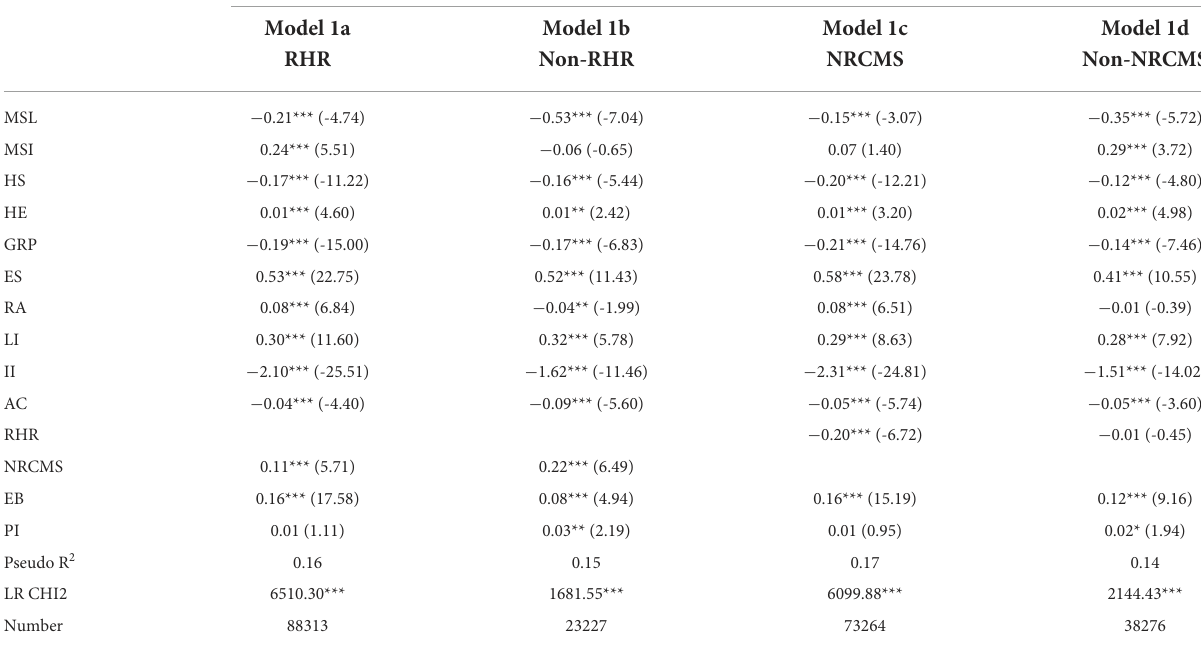
TABLE 4 Results table of Probit regression for different